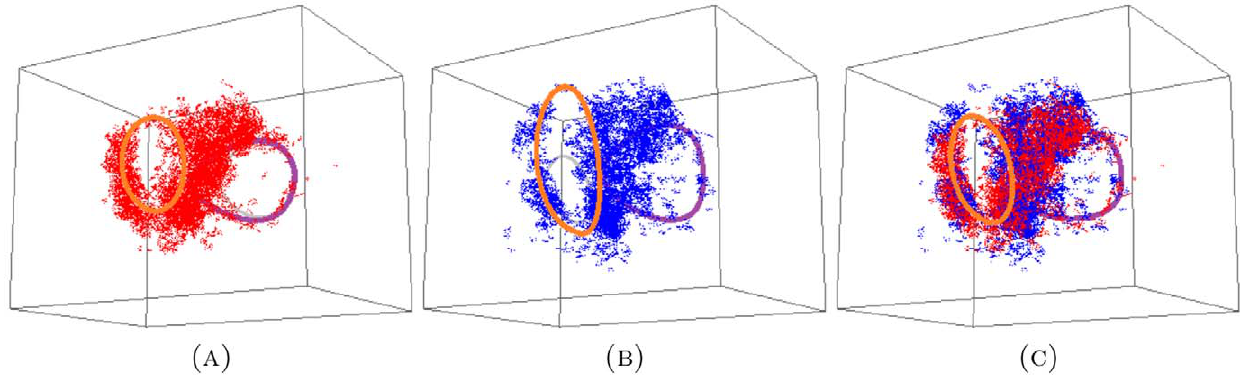
Figure 6. The experimental data for (A) small; (B) medium; and the combined (C) medium + small sets. There are three persistent generators in both the small and medium data sets, but only two persistent generators in the combined set. These two are consistent with two (orange and purple) of the three generators from both the small and medium sets. The voids corresponding to the third generator (grey) in both the small and medium sets are filled in the combined set. In this perspective only the orange persistent generator clearly encircles a void in the data. For a different perspective, showing clearly the purple generator, see Figure S1 and Figure S2.